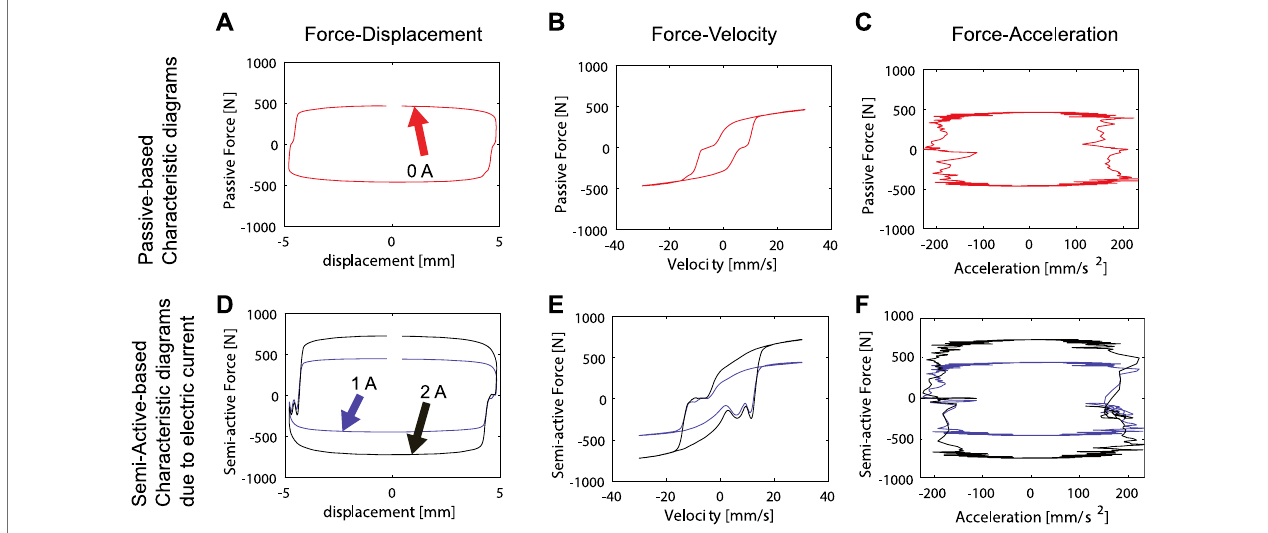
FIGURE 16 | Characteristic diagrams according to the proposed method. The FD , FV and FA characteristics diagrams for p ( fi rst row) and SA (second row) forces agree with speci fi ed types in classi fi cation schemes.